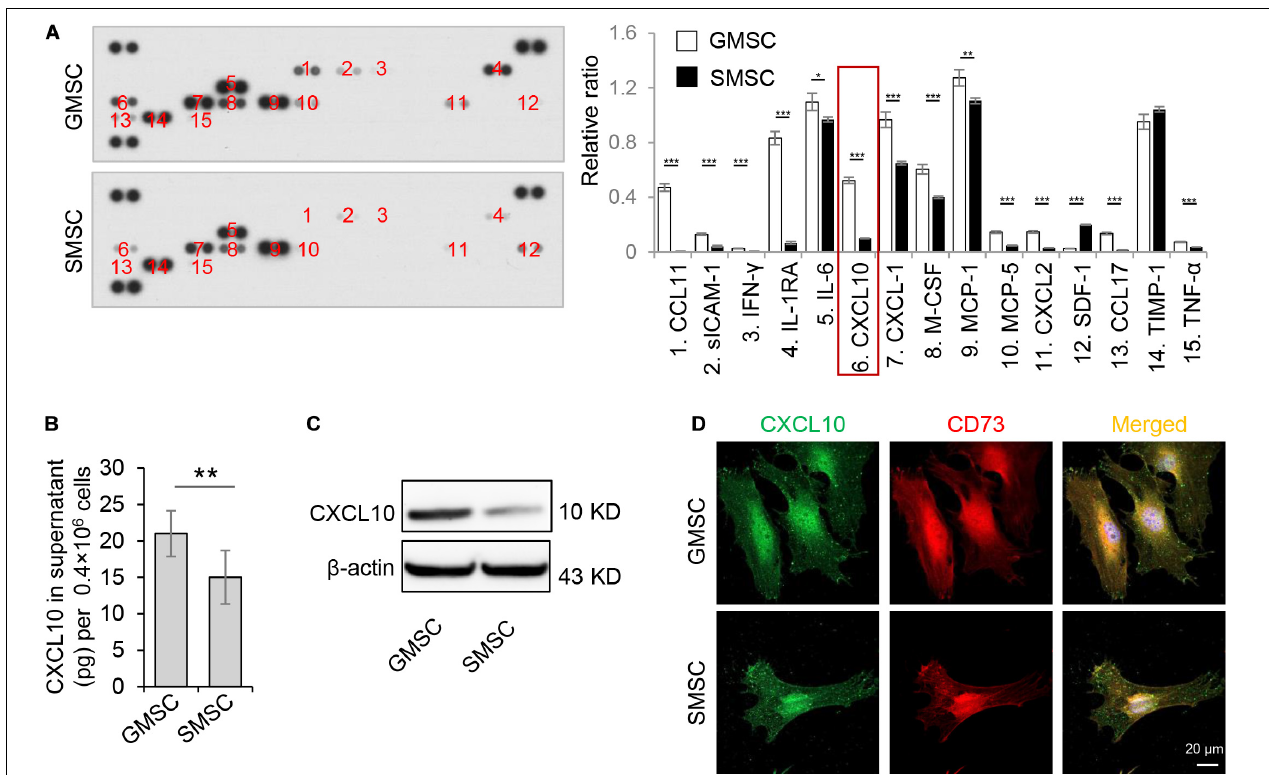
FIGURE 1 | Murine GMSCs produce and secrete higher amounts of CXCL10 than SMSCs. (A) Cytokine array analysis of cytokines in cell culture supernatant from mouse GMSCs and SMSCs. Equal volume of cell culture supernatant were taken from 48 h incubation of 0.4 × 10 6 cells. (B) ELISA analysis of CXCL10 in the culture supernatant of GMSCs and SMSCs. (C) Western blotting analysis showed that the protein expression of CXCL10 was higher in GMSCs than SMSCs. β -Actin was used as a protein loading control. (D) CXCL10 (green) co-expressed with the MSC marker CD73 (red) in GMSCs and SMSCs as analyzed by immunocytofluorescence staining. Scale bar, 20 µ m. All results are representative of data obtained from at least three independent experiments. * P < 0.05, ** P < 0.01, *** P < 0.001. Error bars are means ± SD. Data were analyzed using independent unpaired two-tailed Student’s t